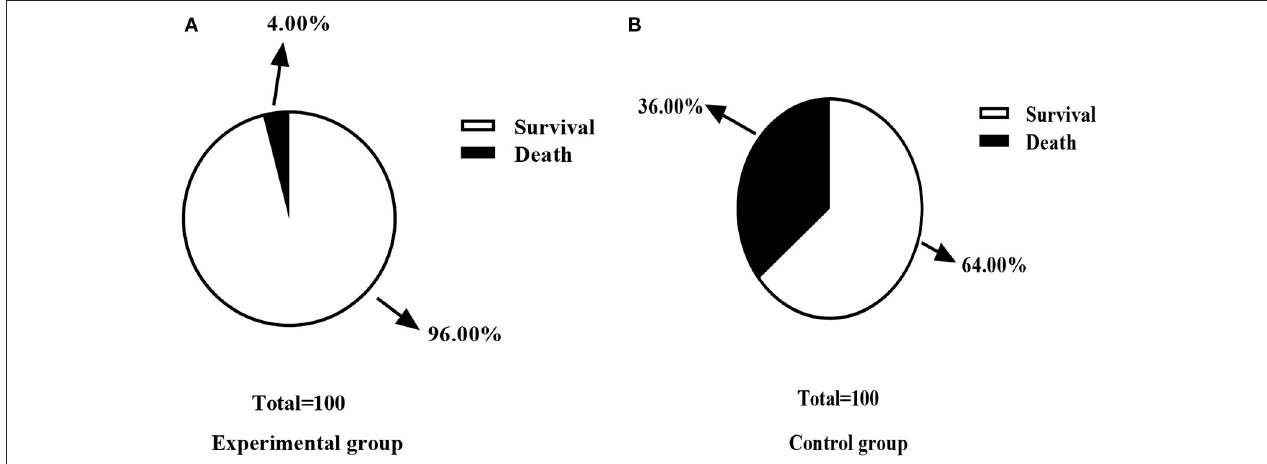
FIGURE 4 | Comparison of mortality rate between control group and experimental group [n (%)]. (A) This figure is the death rate of the experimental group; (B) is the death rate of the control group; In the experimental group, one case of death (4.00%) and 24 cases of survival (96.00%) were recorded. In the control group, nine cases of death (36.00%) and 16 cases (64.00%) of survival were recorded; There was a significant difference in the death rate between the two groups of patients after the treatment ( χ 2 = 8.000, P < 0.05).